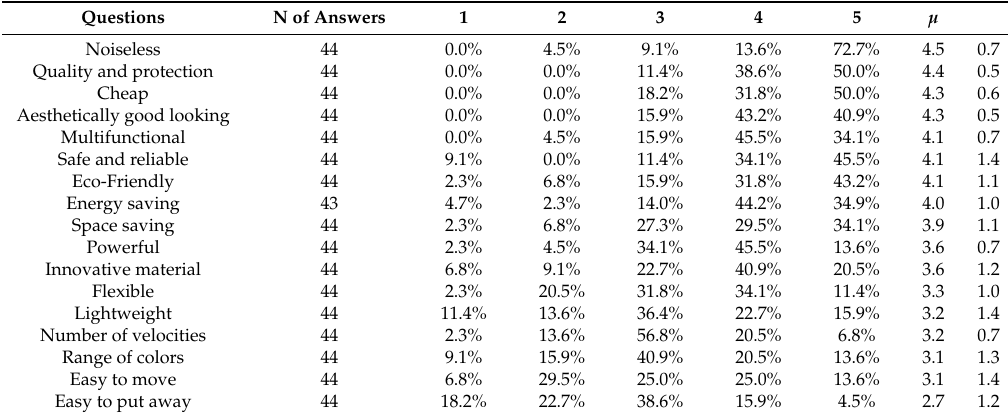
Table 3. Importance of customer